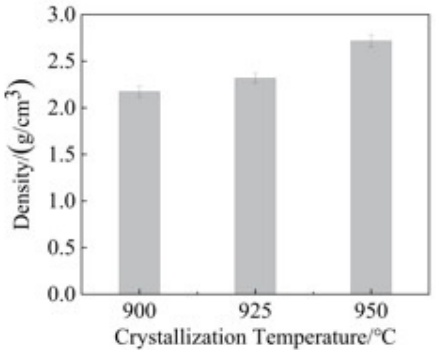
Figure 5. Effects of crystallization temperature on the density of the microcrystalline glass.